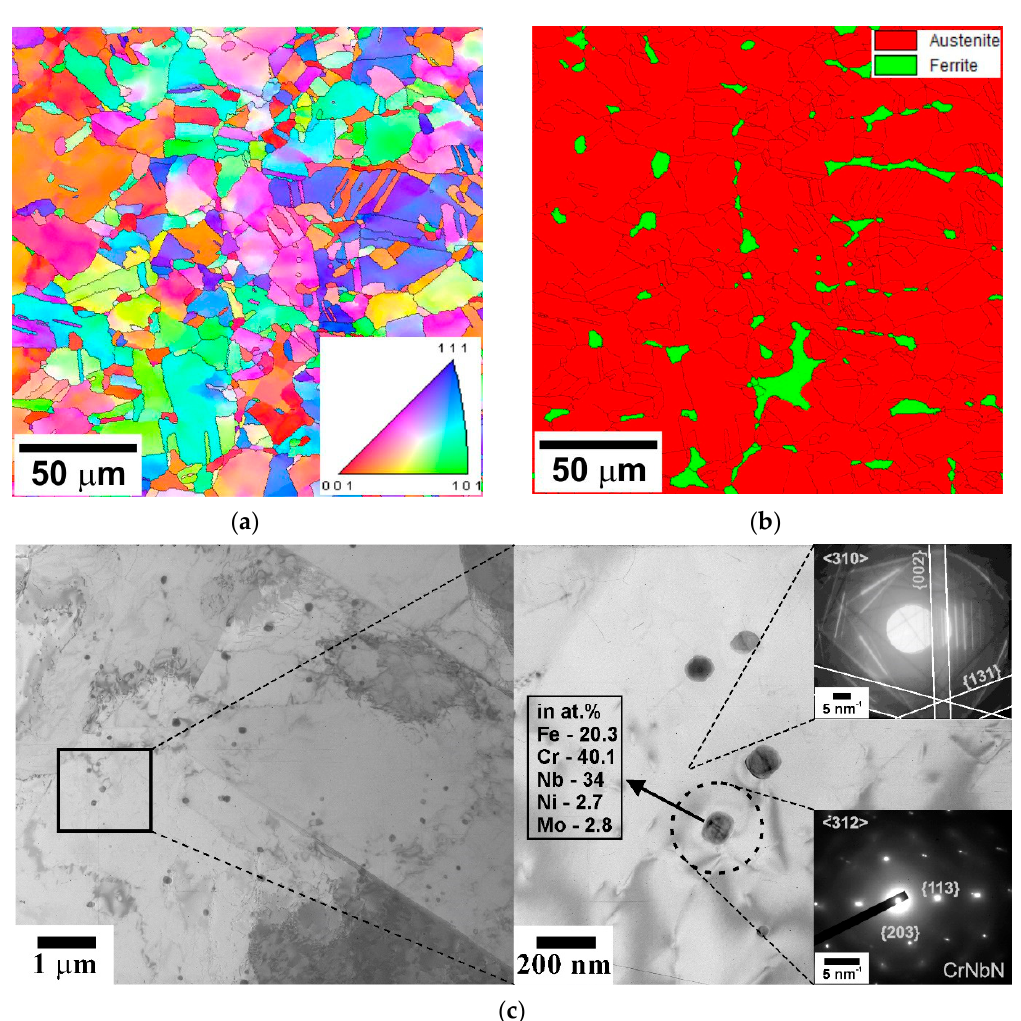
Figure 1. Initial microstructure of a highly-alloyed austenitic stainless steel; typical OIM micrograph ( a ), austenite/ferrite distribution ( b ), and Z-phase particle in the austenite matrix ( c ). High-angle grain boundaries are indicated by black lines in ( a ) and ( b ).